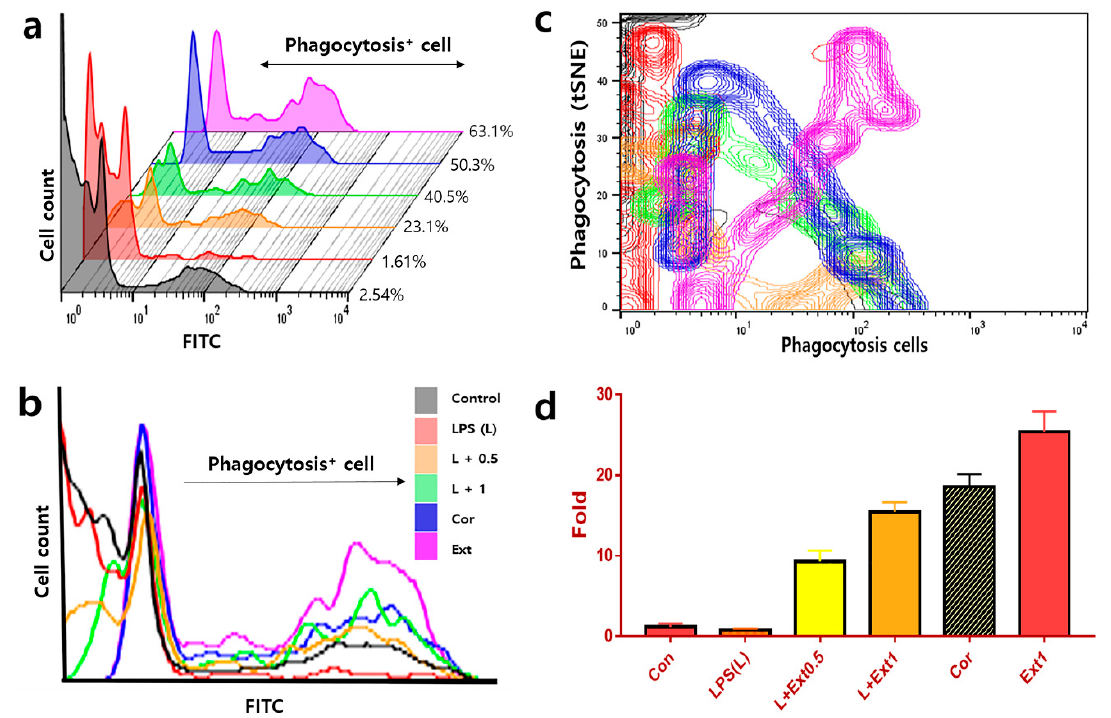
Figure 5. Activation of phagocytosis by Cordyceps militaris extracts in macrophages under LPS stress. Particles of E. coli were labeled with FITC. The phagocytosed macrophages were counted by flow cytometry and were analyzed by FlowJo software 10.6.1. The ( a , b ) (supplement graph for the panel ( a )) panels show histograms of activation of phagocytosis by Cordyceps militaris extracts, and the ( c ) panel shows the visualizing datum using t-SNE for the phagocytosis. Panel ( d ) shows the relative fold changes for phagocytic activation by serial doses of the extract under LPS stress. LPS; lipopolysaccharide, Ext; extract, Cor; cordycepin ( p < 0.05).